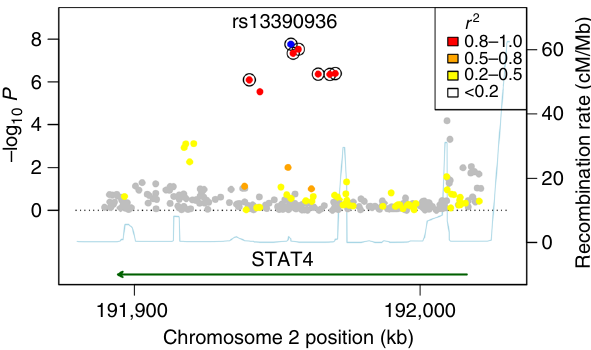
Fig. 1 Association plot of NTS bacteraemia susceptibility at the STAT4 region in Kenyan children. NTS association at the STAT4 region under the recessive model in Kenyan discovery samples ( n = 180 cases, 2677 controls). rs13390936 is highlighted in blue. SNPs are coloured according to the strength of linkage disequilibrium ( r 2 ) to rs13390936. SNPs in a credible SNP set, which includes the causal variant with > 95% probability, are ringed with black